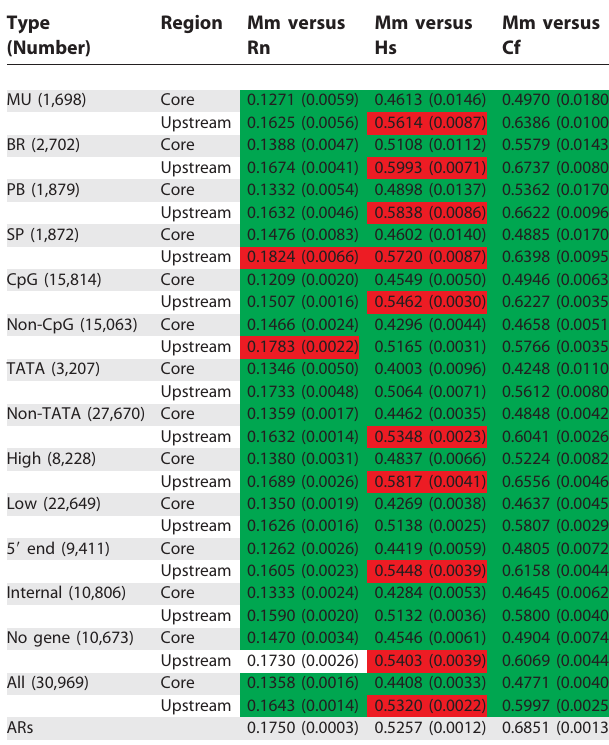
Substitution rate estimates (95% confidence intervals in parentheses) based upon mouse- based alignments for core promoter regions (200 bp immediately upstream of the TSS) and the entire 1.1-kb upstream regions flanking mouse TSSs and ARs. Estimates are given for all promoters considered together ( ‘‘ all ’’ ) and various categories of promoters (with numbers analysed in parentheses): the promoter classes discovered in the CAGE data (MU, BR, PB, and SP), promoters possessing or not possessing CpG islands or TATA boxes, promoters with TSSs supported by 100 or more tags ( ‘‘ high ’’ ) or fewer than 100 tags ( ‘‘ low ’’ ), and promoters at 5 9 ends of genes, internal to genes, or not mapped to genes ( ‘‘ no gene ’’ ). Comparisons are between the mouse sequence and those from rat (Rn), human (Hs), and dog (Cf). Green indicates that the promoters’ evolution has been significantly slower than that of AR (last row), while red indicates significantly more rapid evolution than